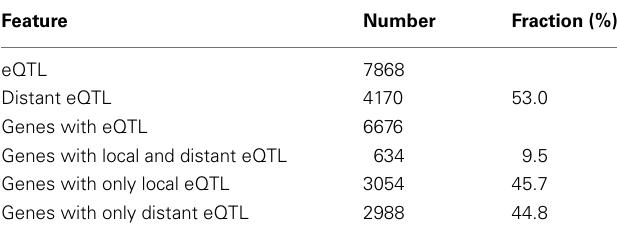
FIGURE 1 | eQTLs, physical position of the top of the eQTL ( x -axis) plotted against the physical position of the gene ( y axis). Both physical positions are in mega basepairs (Mb) and plotted per chromosome (I-V, indicated at the top and right side). eQTLs for local (cis) regulation are in gray